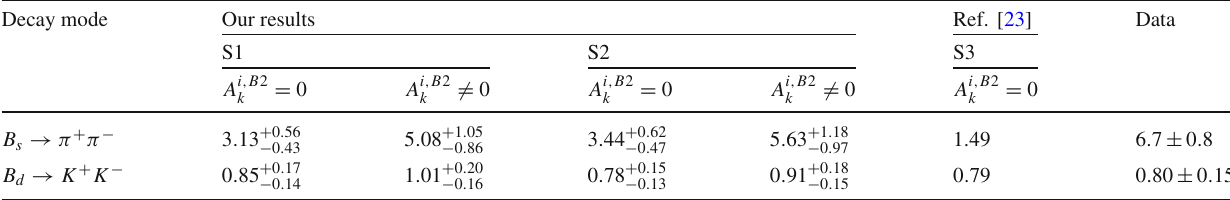
Fig. 3 The contour plots of branching ratios of B d → K + K − and B s → π + π − decays as functions of the annihilation parameters ρ A and φ A without and with the contributions in a , b , respectively. The solid curves correspond to the central values of data and the bands correspond to the 2 σ constraints